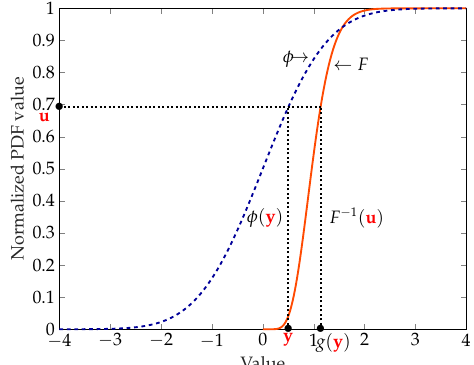
Figure 13. Memoryless transformation used to generate the gamma random field.